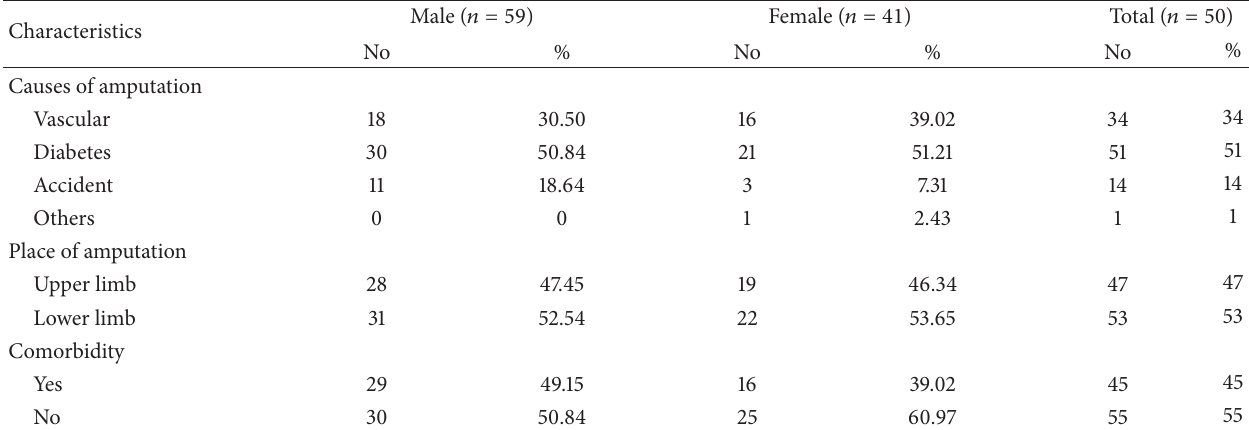
Table 2: Clinical characteristics of the